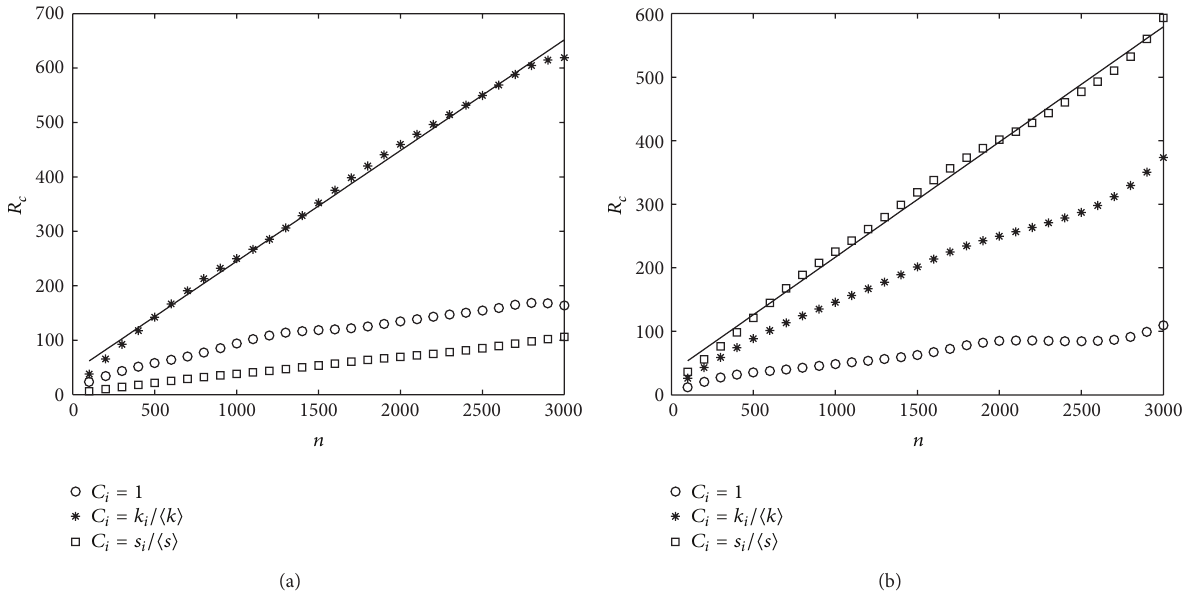
Figure 6: 𝑅 𝑐 versus 𝑛 . BBV network with 𝛿 = 6 , 𝑚 = 6 , and 𝜔 0 = 1 . (a) 𝛼 = 0.1 , (b) 𝛼 = −0.2 .